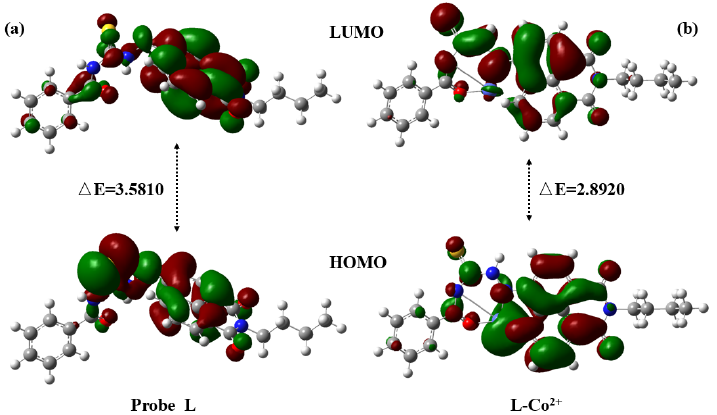
Figure 8. The energy-minimized structures of (a) L and (b) the L -Co 2+ complex.